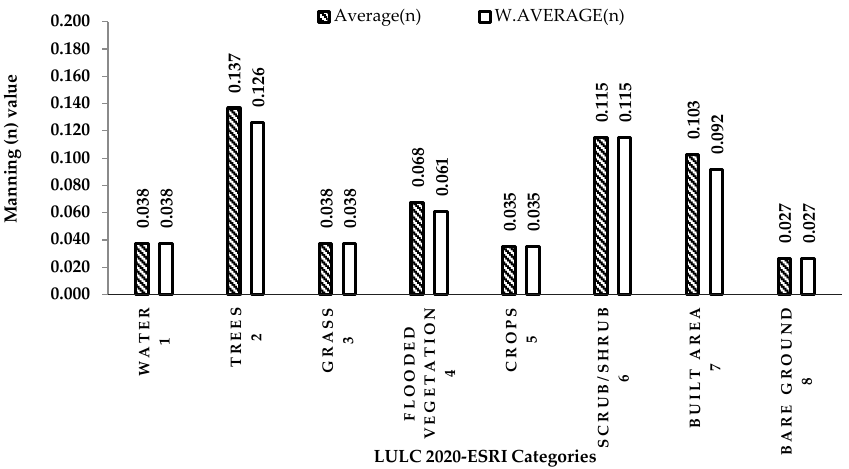
Figure 8. LULC 2020-ESRI base Manning’s roughness values using both average and weighted average methods.